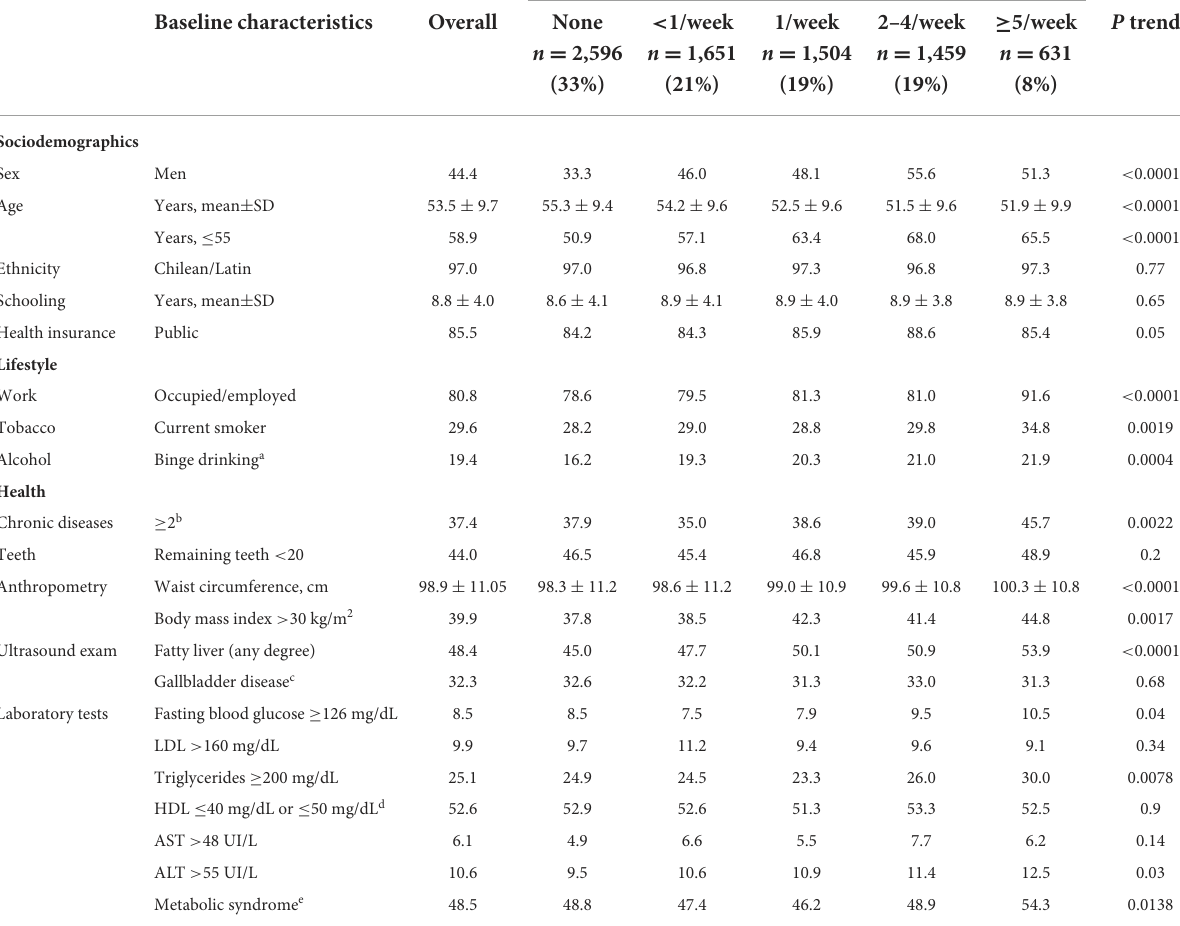
TABLE 1 Profile of participants by weekly frequency of processed meat consumption.